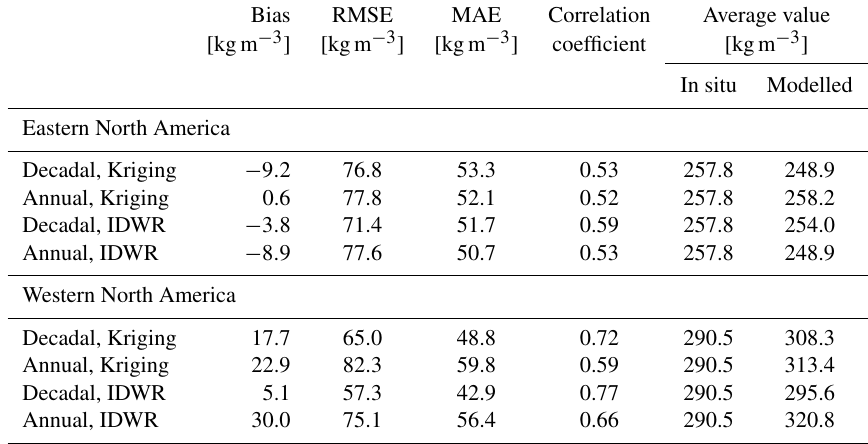
Table A1. Validation parameters of different snow densities for eastern (east of 90 ◦ W) and western North America. Bias RMSE MAE